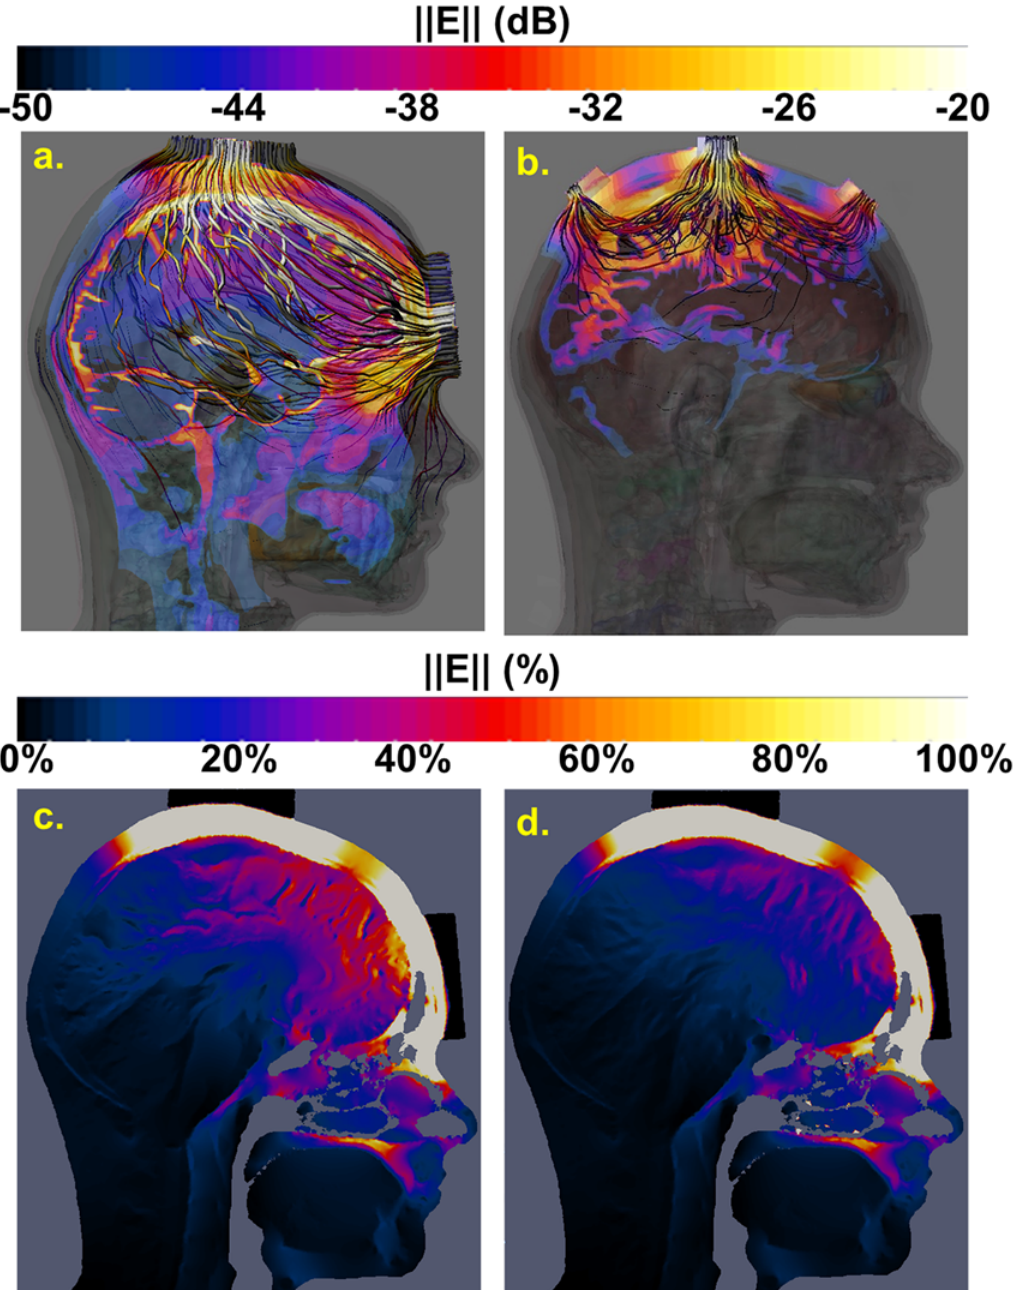
Fig 9. tACS modeling (Top). Comparison of two montages of stimulus electrode configurations. Sagittal view of the simulated magnitude of the electric field through the eye and of the current density stream lines for the (Fpz-Cz) montage (a) and the Cz-(Fz, C3, C4, Pz) montage (b). The first montage generated higher currents through the eye globe, which includes the retina, compared to the latter montage. (Bottom) Comparison of tissue-specific scalar vs. image- based tensorial electrical properties. Simulated magnitude of the electric field resulting from the (Fpz-Cz) montage tACS based on tissue-specific scalar electrical conductivity values (c) and DTI-based anisotropic values in brain tissues (d). DTI-based conductivity reduces the predicted field strength in the brain. The scale was set to dB (top) and linear (bottom) for visualization purposes.